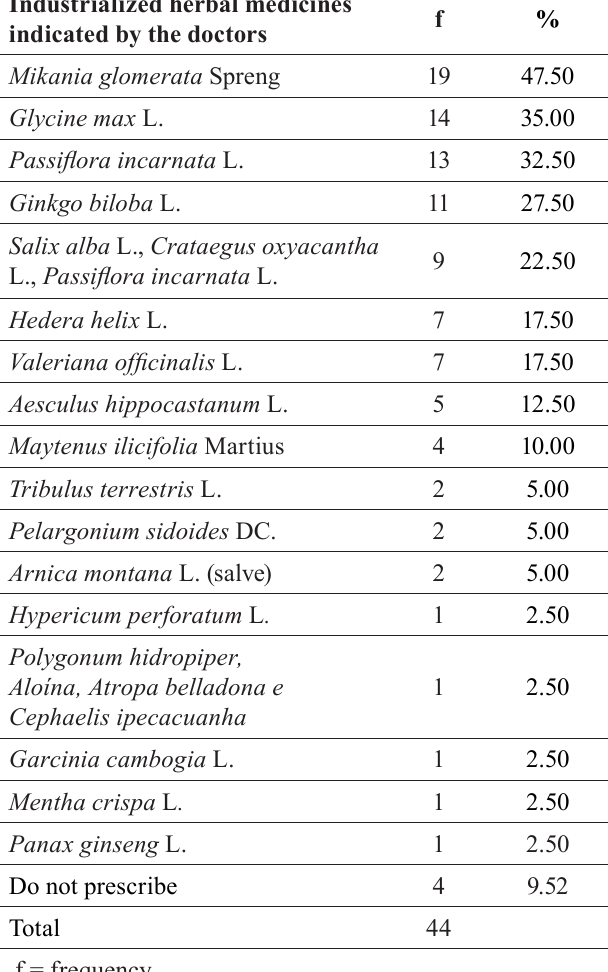
TABLE I – R elation of the industrialized herbal medicines indicated by the medical professionals Industrialized herbal medicines indicated by the